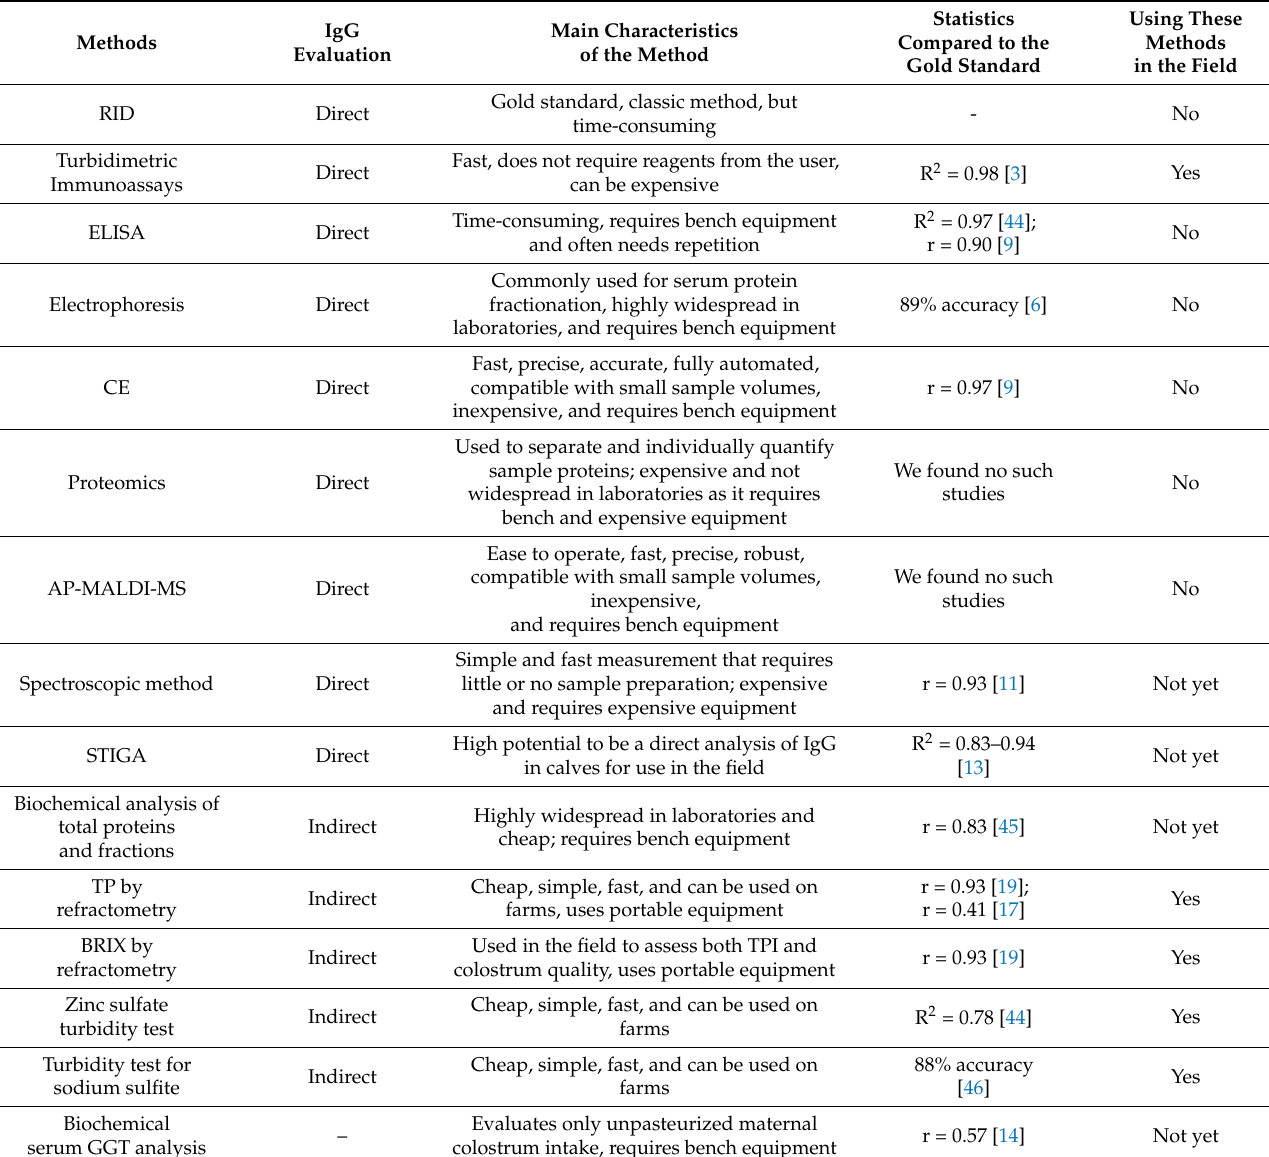
Table 1. The classification of transfer of passive immunity (TPI) assessment methods according to the IgG evaluation method, principle of operation, main characteristics, statistics compared to the gold standard, cost of the method, and possibility of using these methods in the